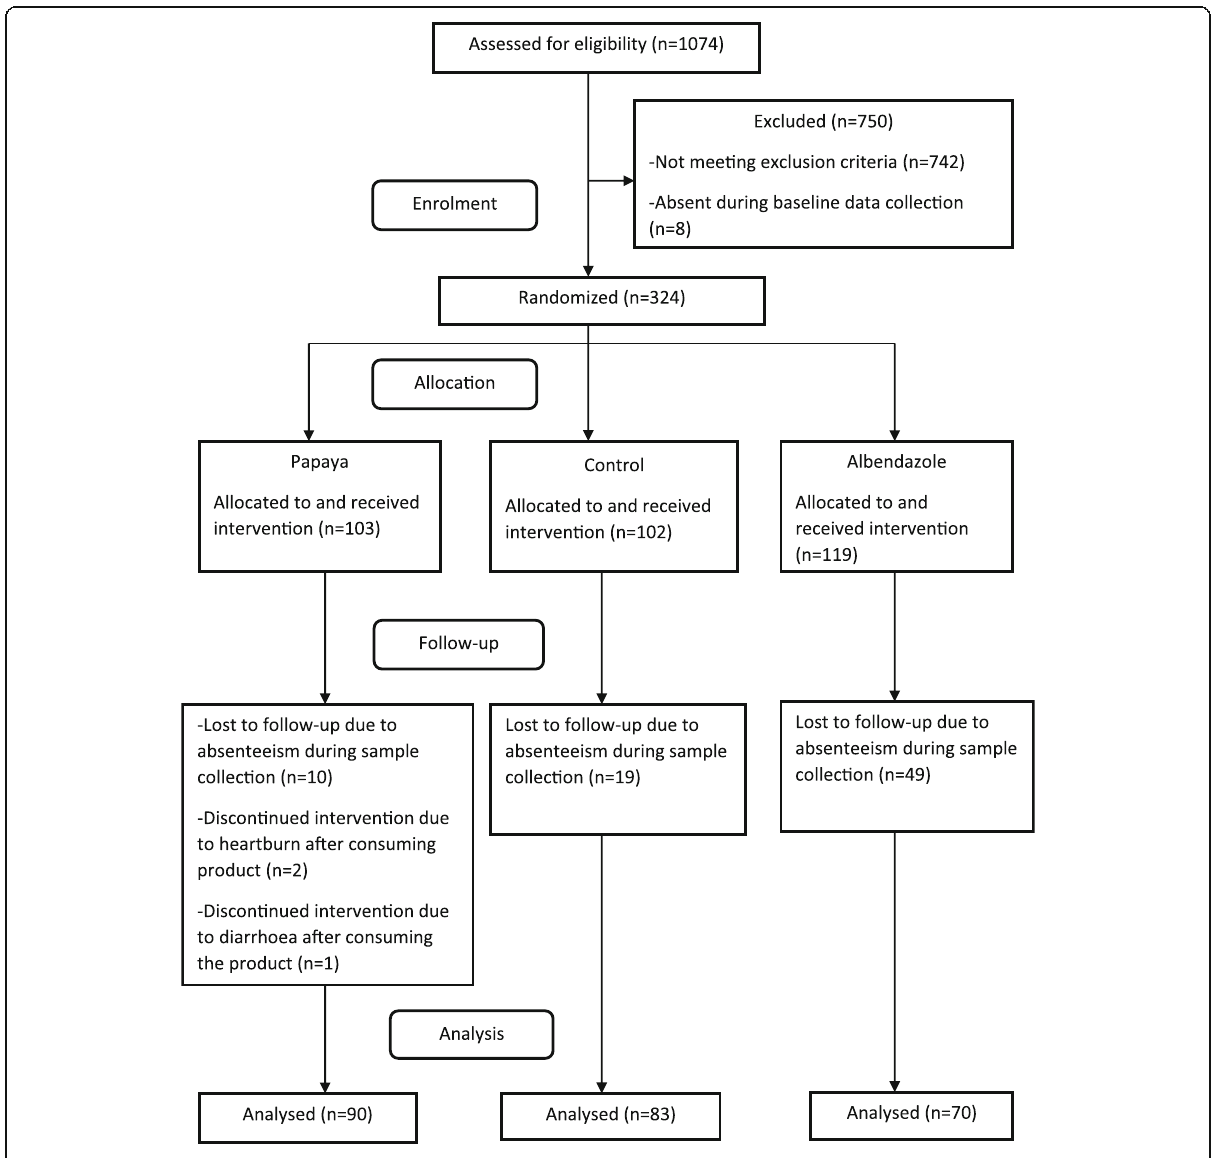
Fig. 1 The flow chart summary of the study